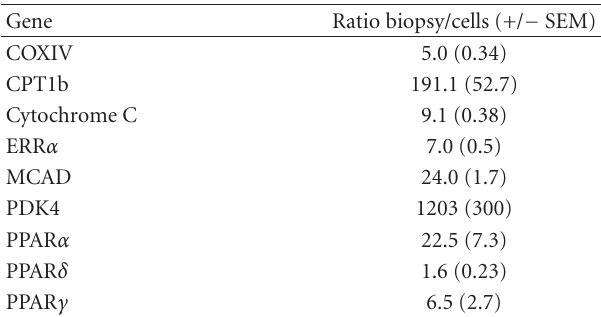
Table 1: Ratio of mean mRNA expression levels in skeletal muscle biopsies compared to cell cultures. mRNA was isolated from muscle biopsies and cultured myotubes, and expression was assessed by RT- PCR, as described in Materials and Methods. Values are presented as mean ± SEM of 4 experiments, each representing one donor, with 3 replicates each, and normalized to levels of the housekeeping gene